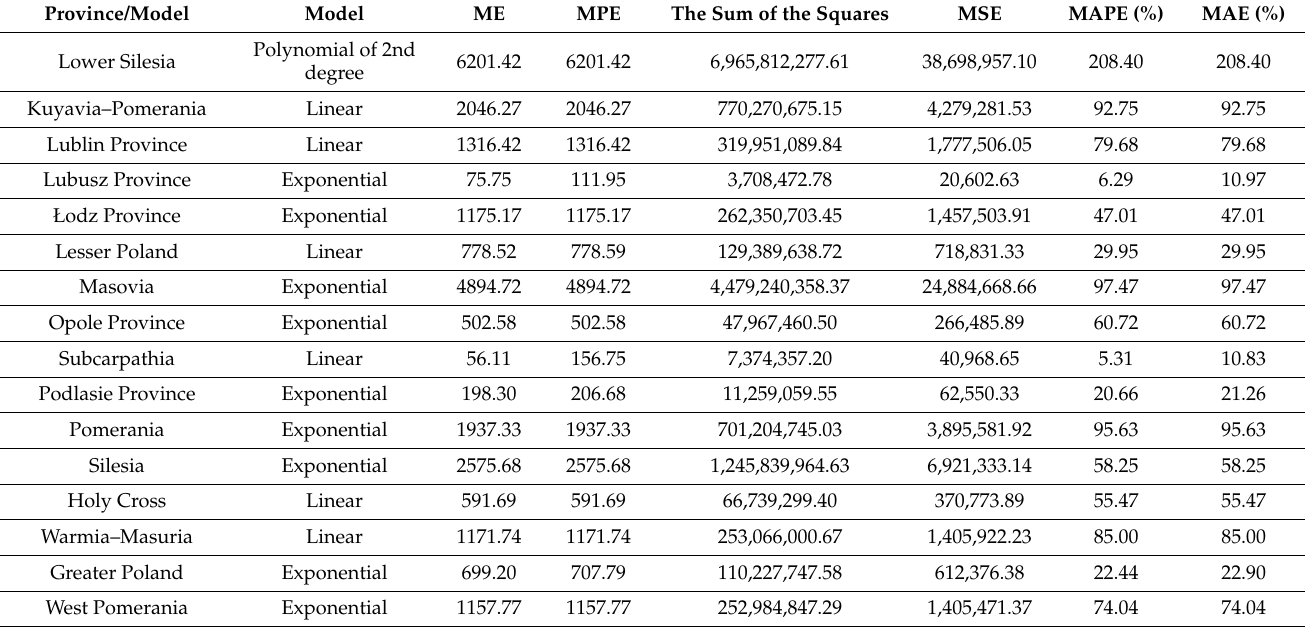
Table 5. Summary of errors for monthly